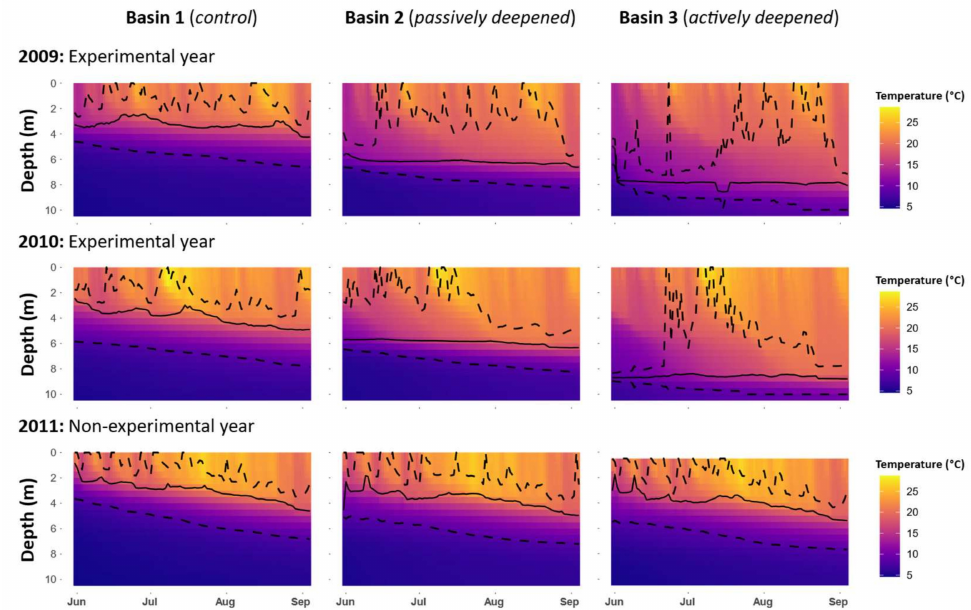
Figure 3. Contour plots of temperature at each depth in 2009, 2010 and 2011 in each of the three basins. The solid line represents the thermocline depth (computed daily), while the dotted lines represent the limits of the